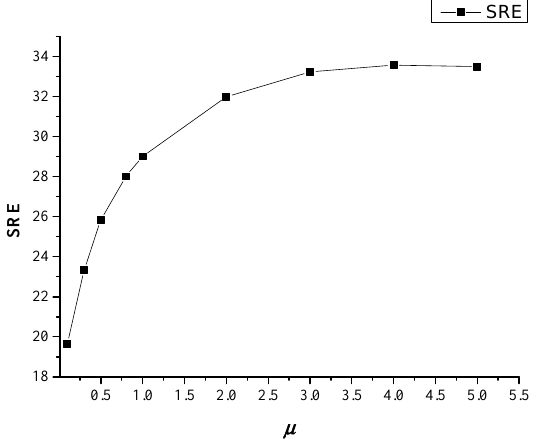
Figure 13. Sensitivity analysis for the Lagrangian multiplier, μ in RGSU with simulated dataset 1.